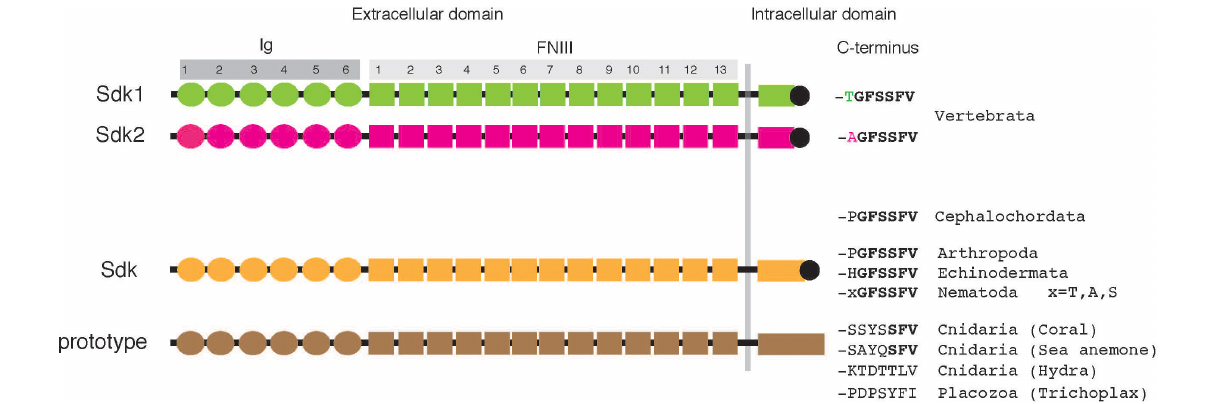
Frontiers in Molecular Neuroscience |